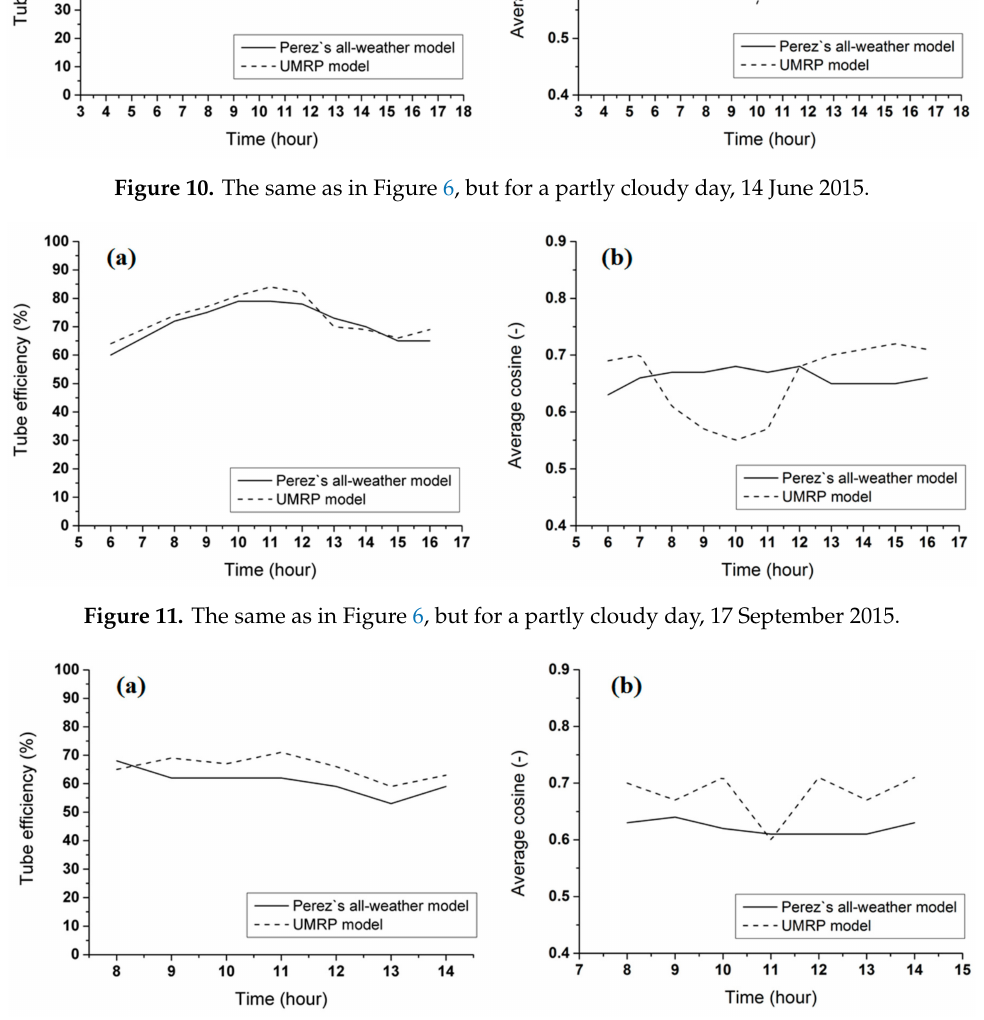
Figure 12. The same as in Figure 6, but for a partly cloudy day, 10 December